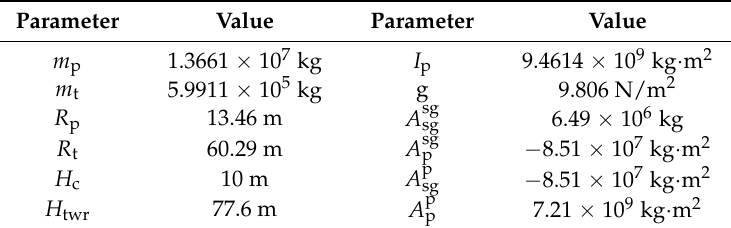
Table 2. Known parameters of the dynamic